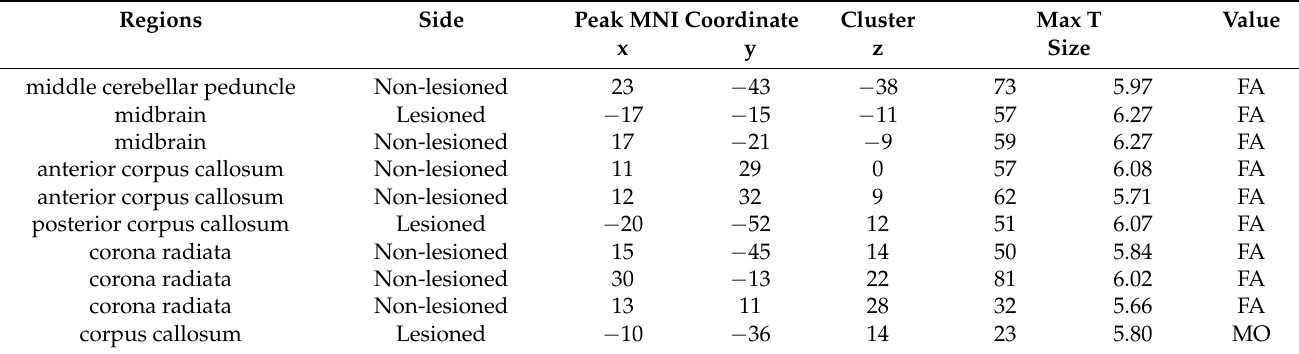
Table 2. Result of regression analysis associated with functional ambulation